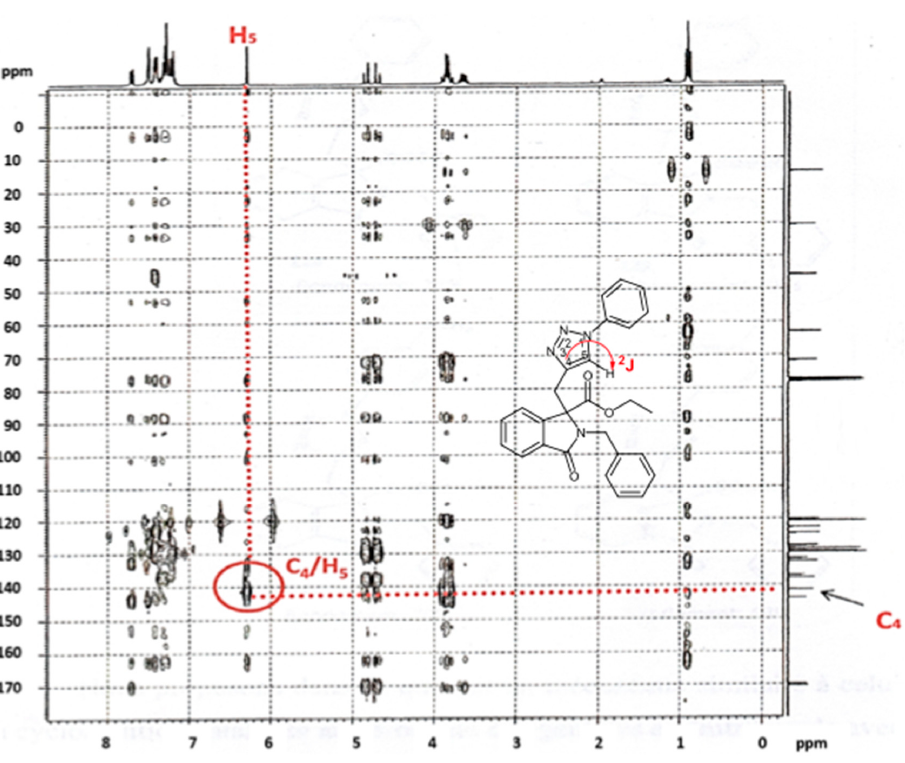
Figure 5. HMBC correlation spectrum of 6a .